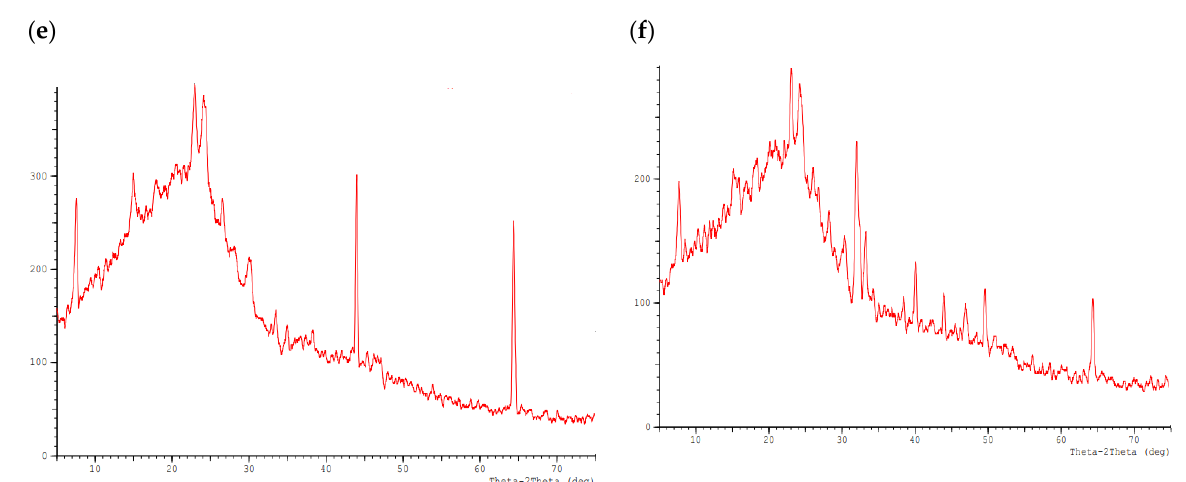
Figure 1. X-ray diffraction (XRD) spectra of apple biochar ( a ), grape biochar ( b ), mixture of apple and grape biochars (1:1) ( c ), HCl modified biochar ( d ), H 3 PO 4 modified biochar ( e ) and rock phosphate modified biochar ( f ).